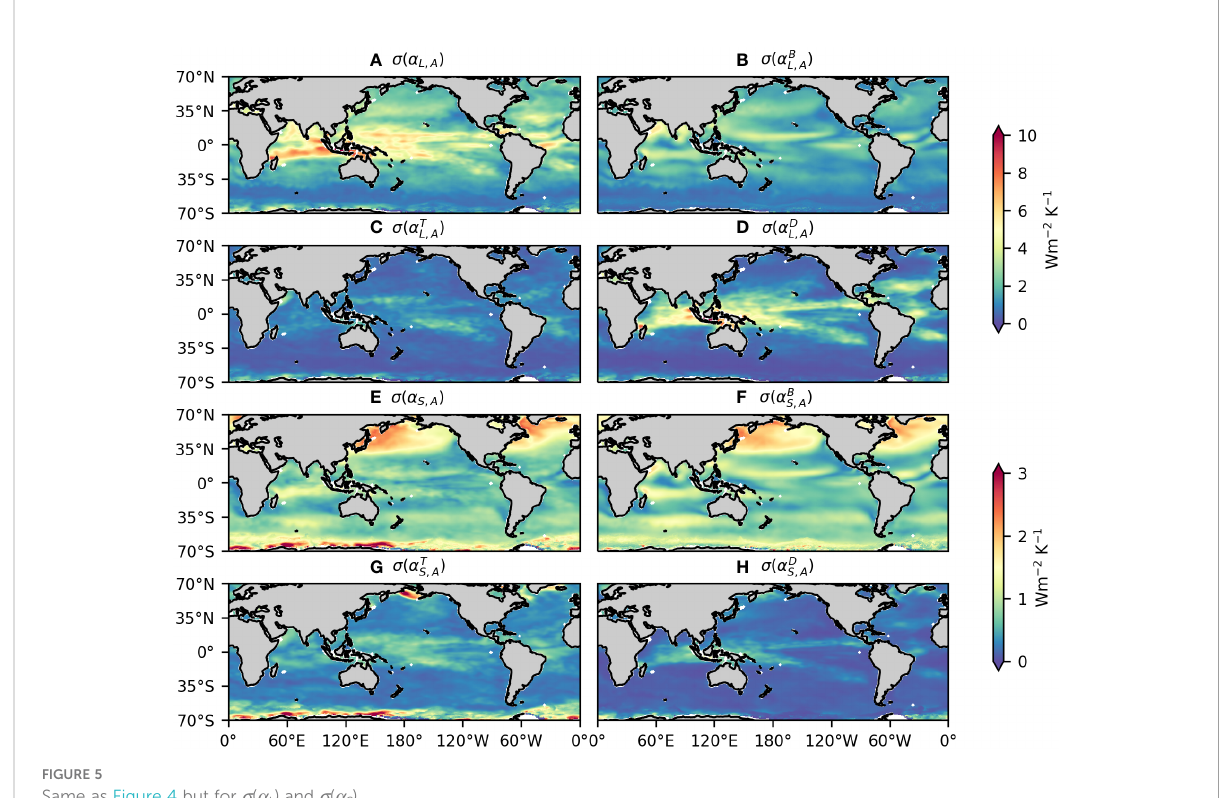
FIGURE 5 Same as Figure 4 but for s ( a L ) and s ( a S ) .